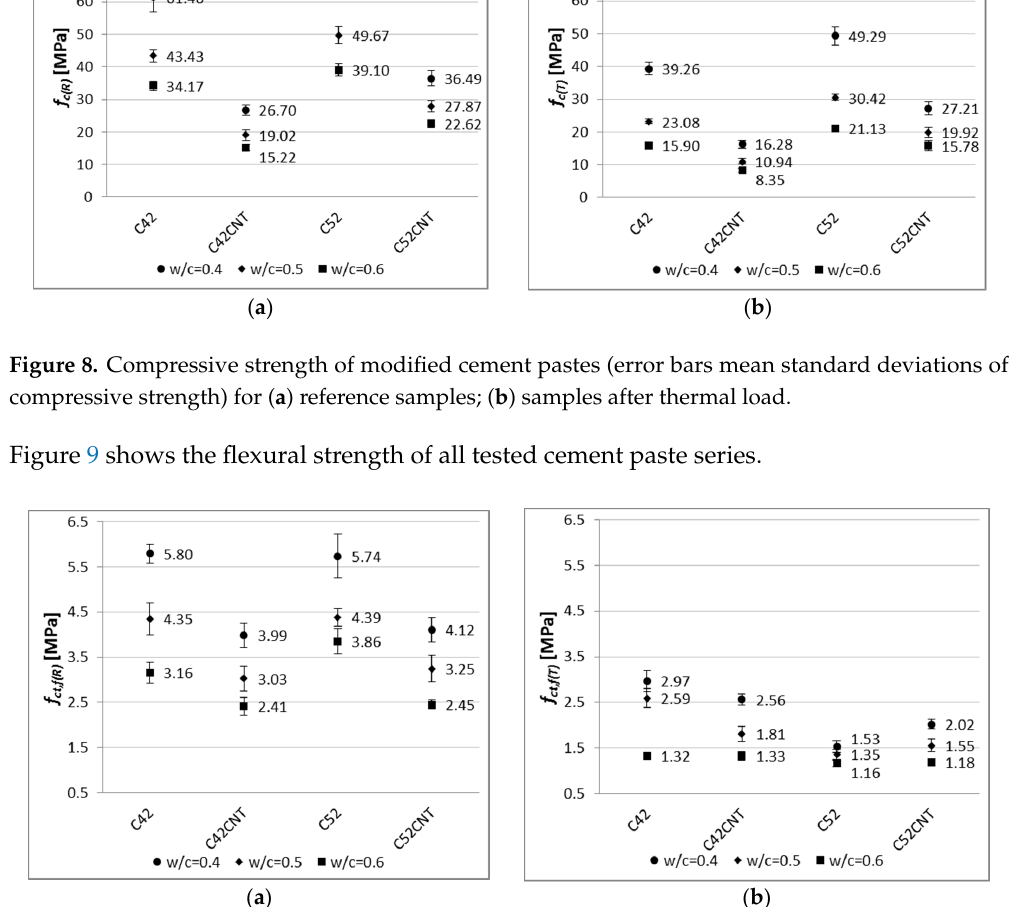
Figure 9. Flexural strength of modified cement pastes (error bars mean standard deviations of flexural strength) for ( a ) reference samples; ( b ) samples after thermal load.